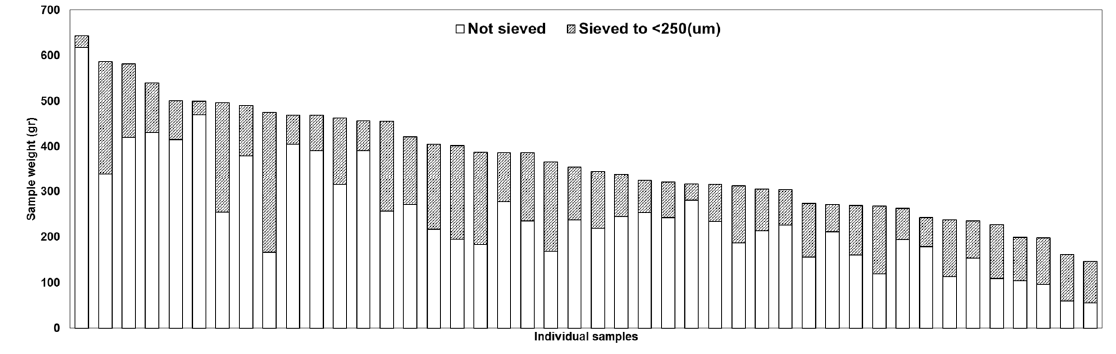
Figure 1. Weight of samples distribution from largest to smallest. Two portions can be seen: The first after homogenization, and the second after sieving to <250